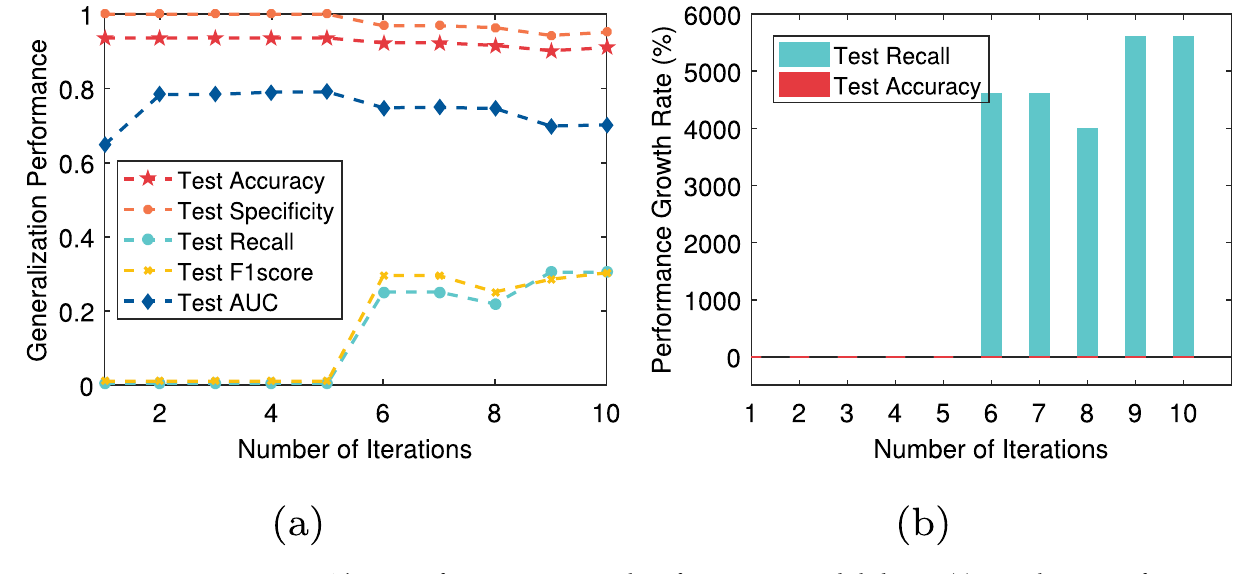
Figure 6. The test performance versus number of iteration on Pri_diab dataset: ( a ) generalization performance; ( b ) performance growth rate.